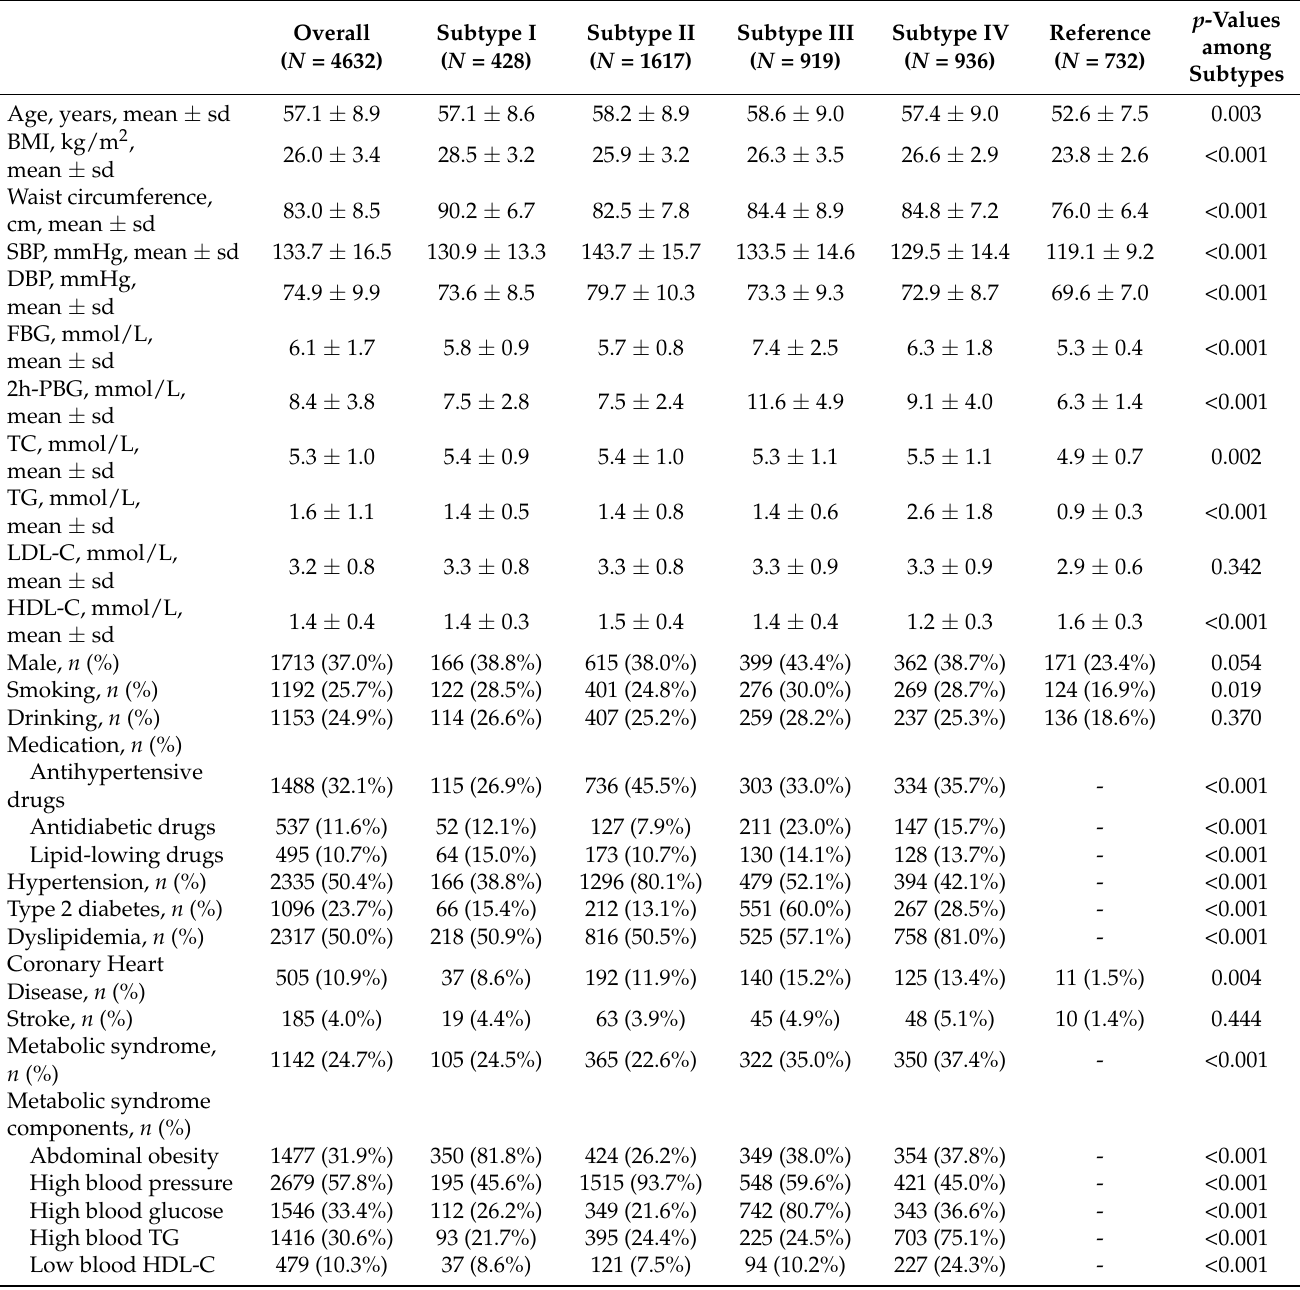
Table 1. Characteristics of the studies with respect to five inferred metabolic subtypes